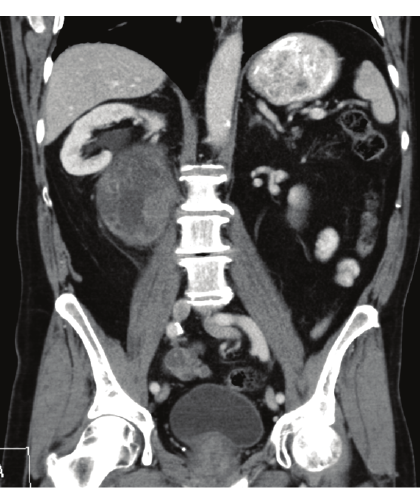
Figure 1: Right retroperitoneal mass displacing right